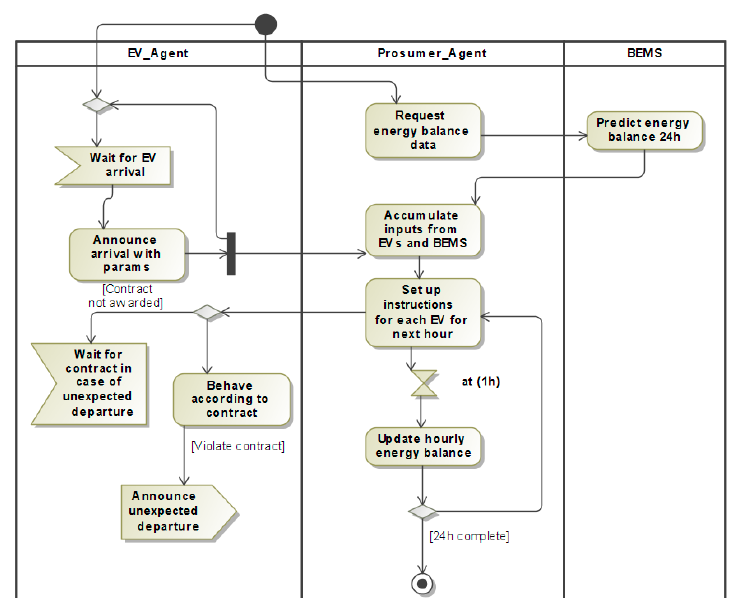
Figure 3. The interaction protocol between the prosumer and EVs in a form of UML activity diagram.